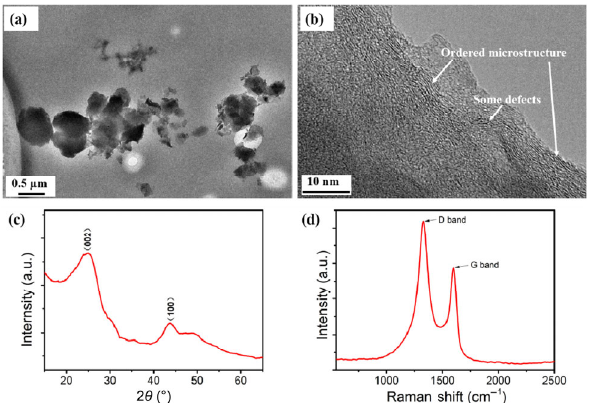
Fig. 2 Micromorphology and microstructure characteristics of TRGO. (a)–(b) TEM image (TRGO sheets were dispersed on a copper mesh support film), (c) XRD diffraction, and (d) Raman